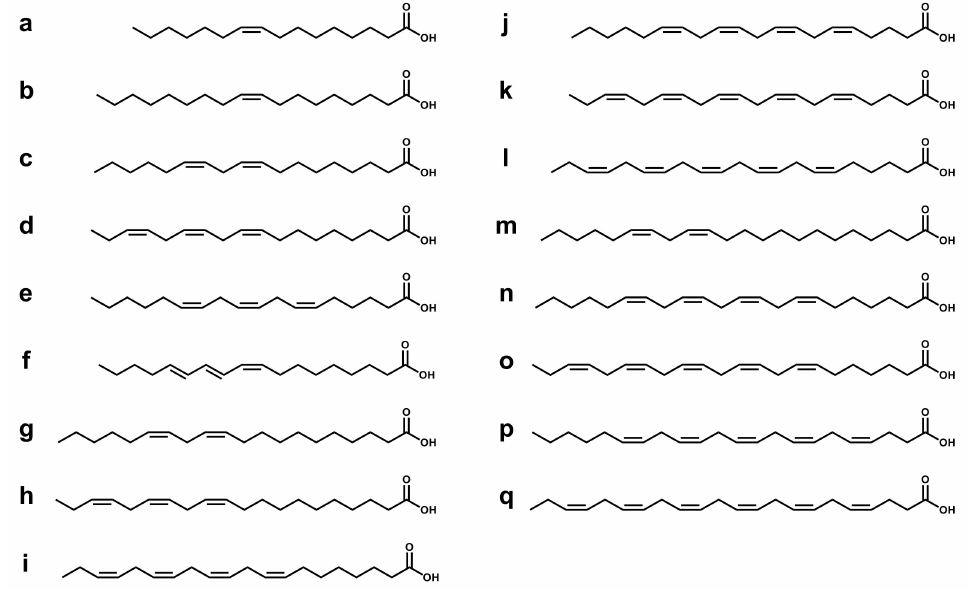
Figure A2. Chemical structures of unsaturated fatty acids tested in this study. ( a ) Palmitoleic acid; ( b ) oleic acid; ( c ) linoleic acid; ( d ) α -linolenic acid (ALA); ( e ) γ -linolenic acid; ( f ) α -eleostearic acid; ( g ) eicosadienoic acid; ( h ) eicosatrienoic acid; ( i ) ω -3 eicosatetraenoic acid; ( j ) arachidonic acid ( ω -6 eicosatetraenoic acid); ( k ) eicosapentaenoic acid (EPA); ( l ) henicosapentaenoic acid; ( m ) docosadienoic acid; ( n ) docosatetraenoic acid; ( o ) ω -3 docosapentaenoic acid; ( p ) ω -6 docosapentaenoic acid; ( q ) docosahexaenoic acid